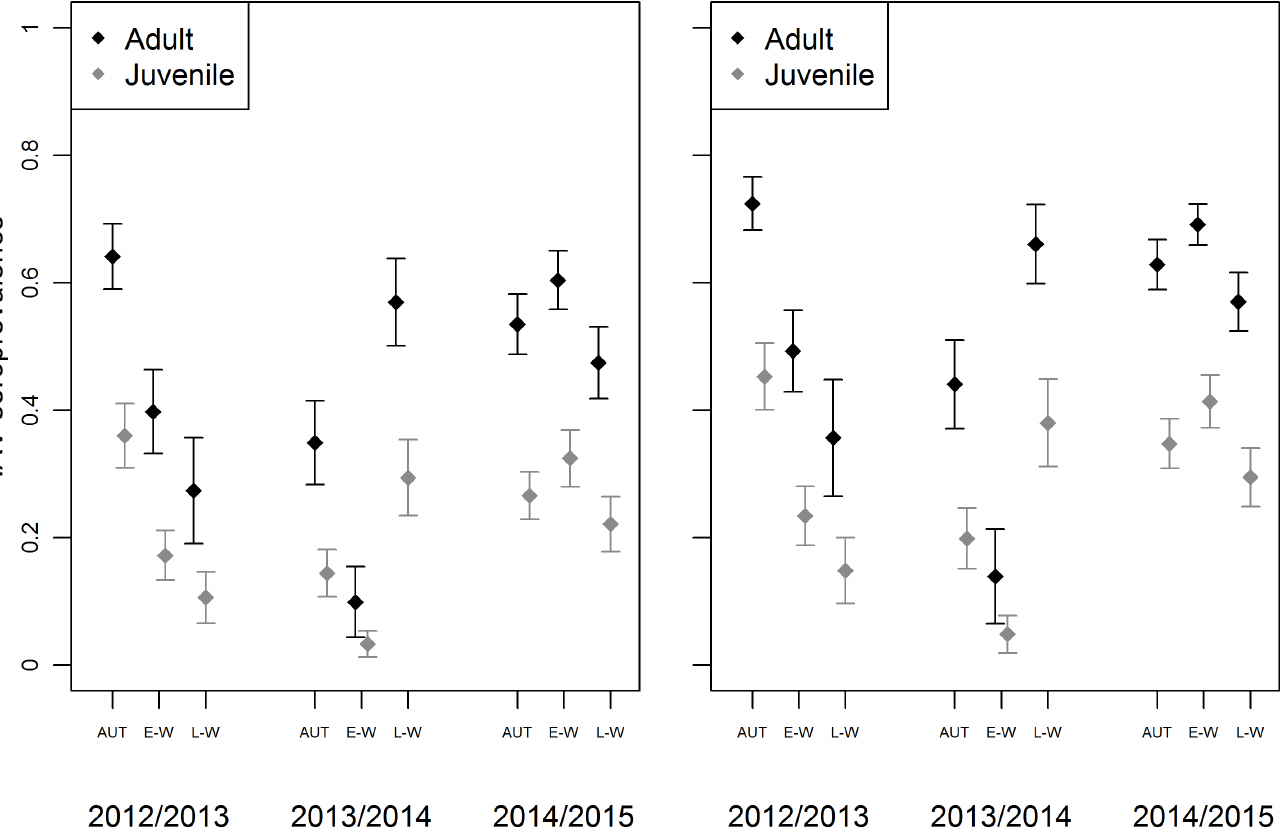
Fig 2. Estimated influenza A virus (IAV) seroprevalence ( ± SE) for female (left) and male (right) mallards. Mallards were captured and sampledin Fairbanks and Anchorage, Alaska duringAugust–April of 2012–2015.Estimates represent seroprevalence in autumn (AUT; Aug–Oct), early-winter (E-W; Nov–Jan), and late-winter (L-W;